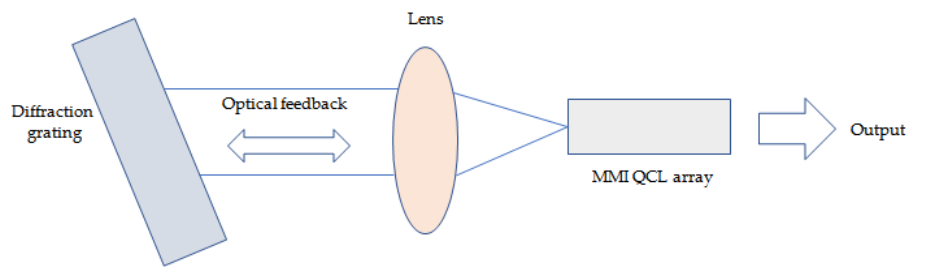
Figure 7. MMI structure of an ECQCL.